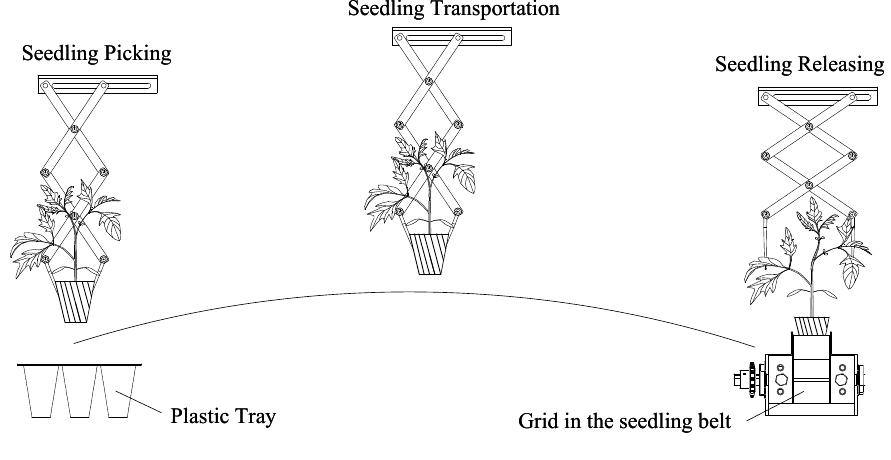
Figure 3. Procedure diagram of seedling picking.